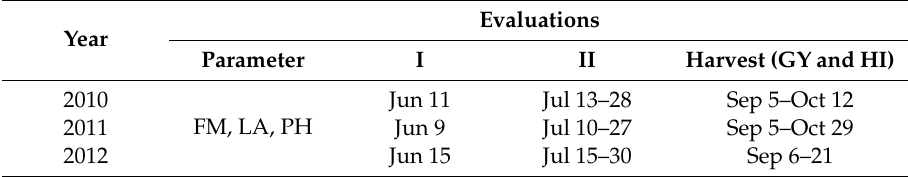
Table 4. Evaluation